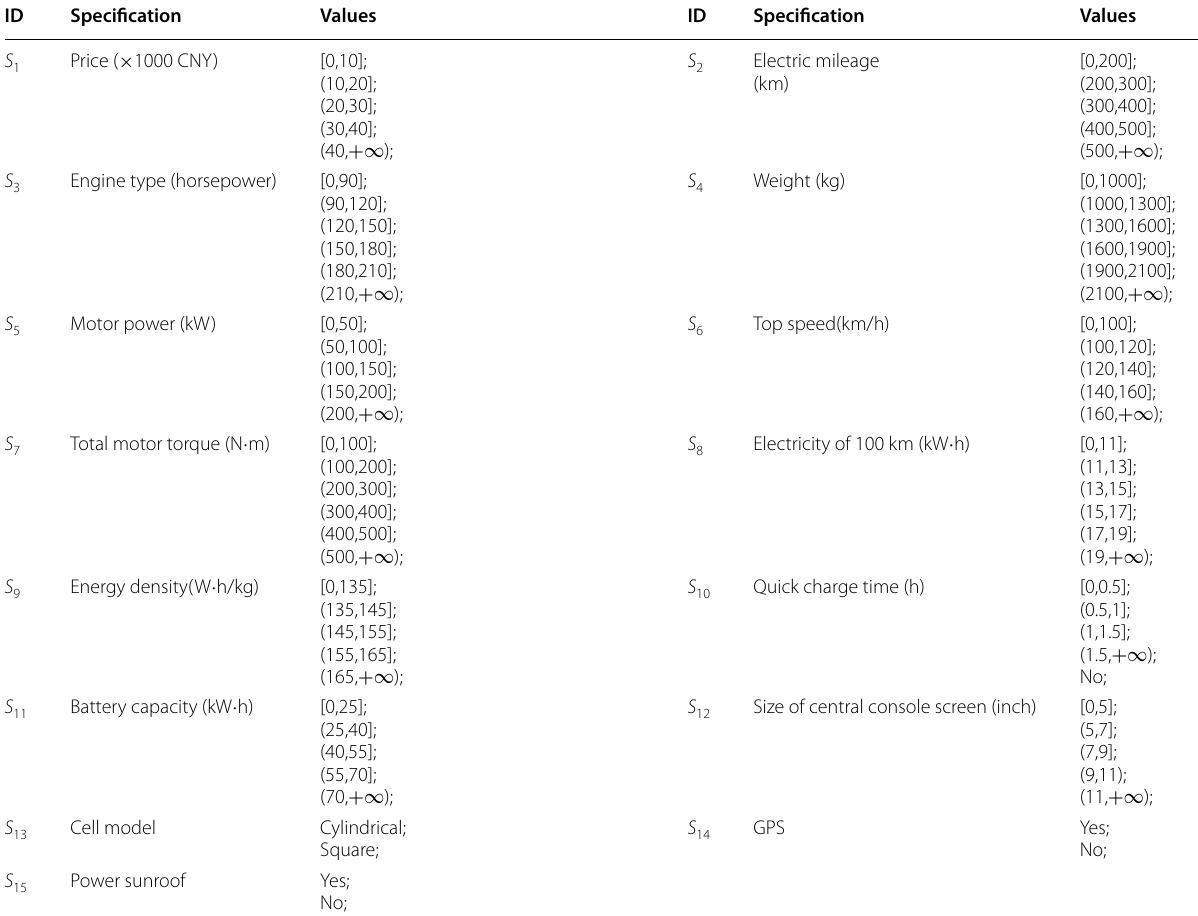
Table 4 Product specifications and